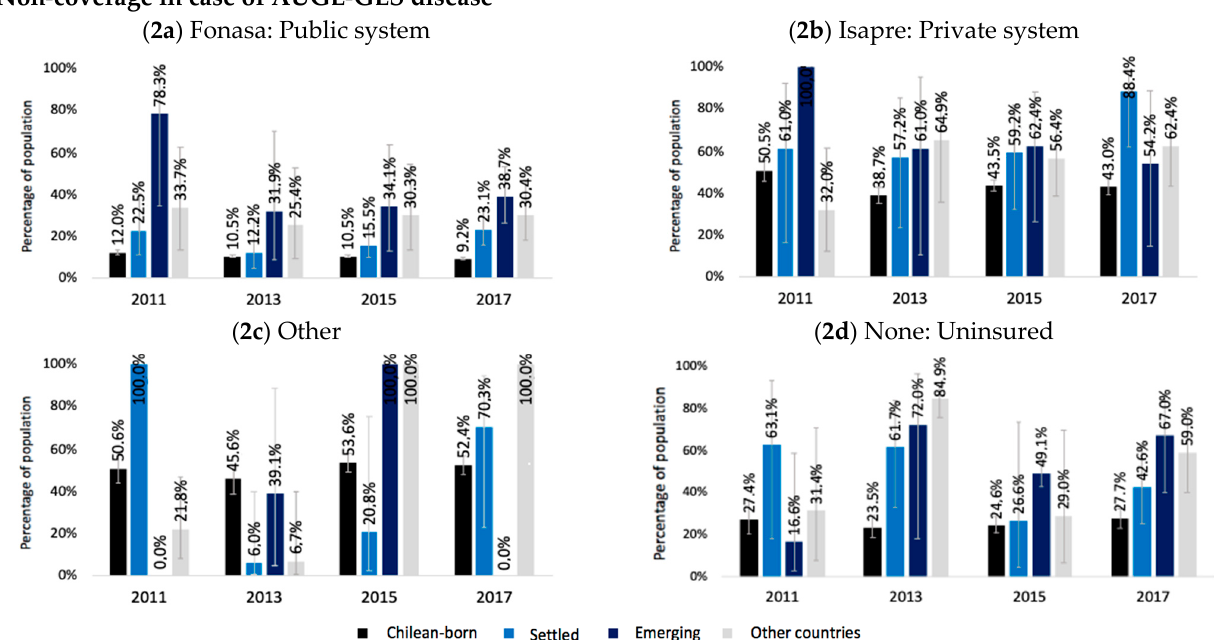
Figure 2. Unexpressed demand: No consultation in case of illness or accident during the three months before the survey and non-AUGE-GES coverage in the Chilean-born population and immigrant population (settled, emerging, and other countries). Chile 2011–2017. Settled: Peru, Argentina, Bolivia, Ecuador. Emerging: Venezuela, Dominican Republic, Colombia, Haiti. Others: Migrants from other countries: remaining countries and does not know, does not respond to country of origin. 1. Percentage of the total population with illness or accident during the three months before the survey. 2. Percentage of the total population on treatment due to any AUGE-GES disease (12 months prior to the survey).